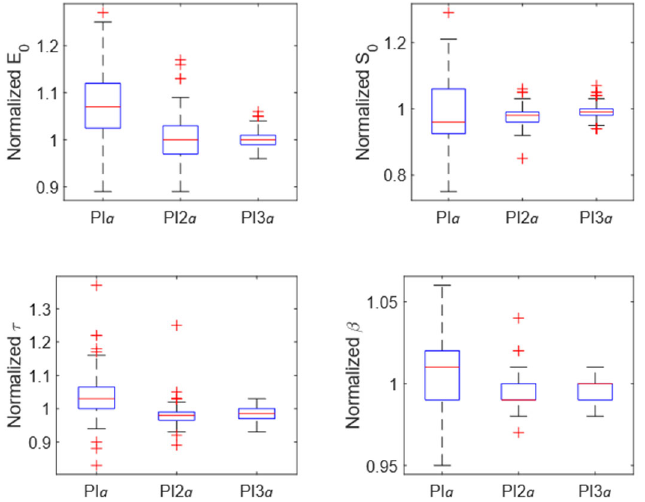
Figure 3. Box plots of the normalized values of E 0 ( top left ), S 0 ( top right ), τ ( bottom left ), and β ( bottom right ) for PI a , PI2 a , and PI3 a